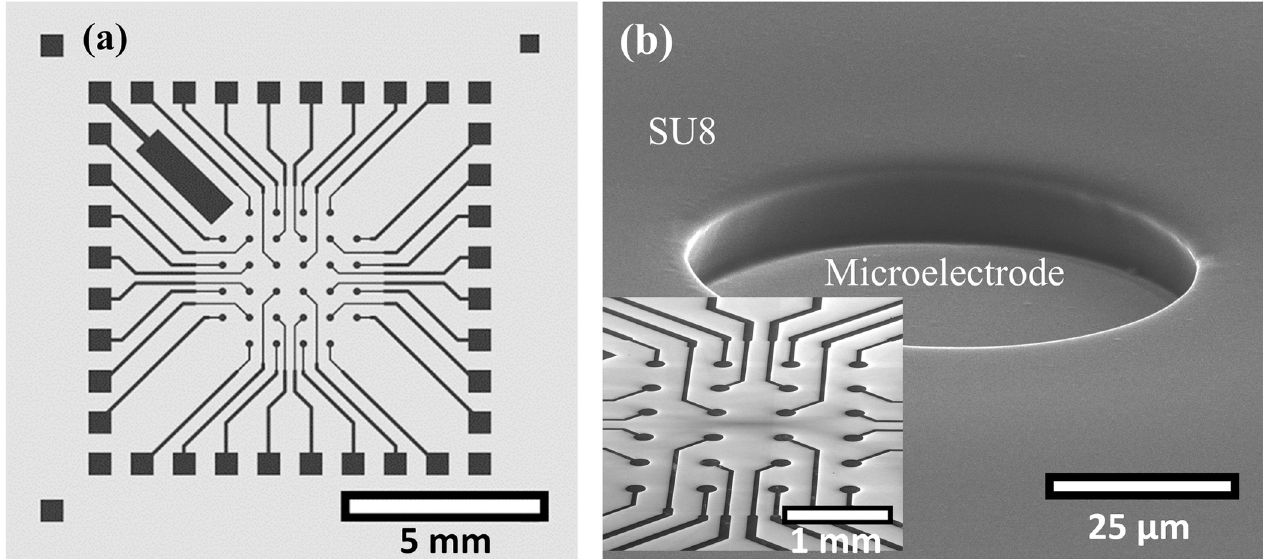
Fig 1. (a) Microelectrode configuration. (b) SEM image of fabricated planar microelectrode with a SU8 passivation layer. Inset in (b) shows an SEM image of the planar microelectrode overview without the SU8 passivation layer. The SEM images were taken at 70˚ tilted-view.